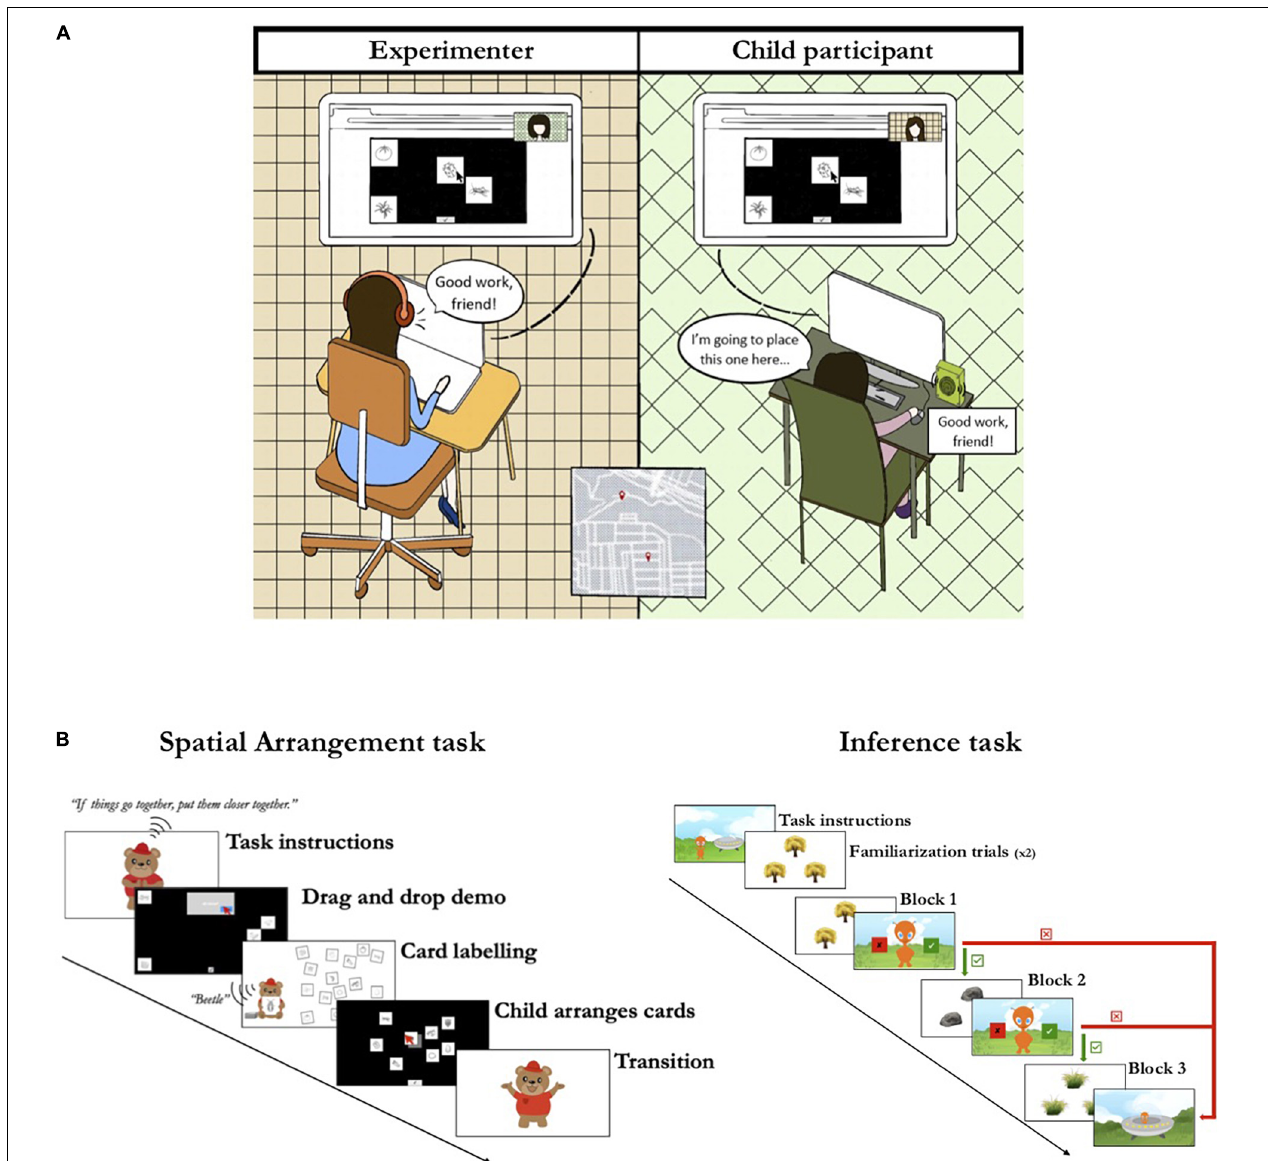
FIGURE 2 | Experimental procedures. (A) Illustration of the experimental setup. Children were tested remotely by a trained experimenter in the Zoom platform. Children completed the tasks on a browser window; the child shared their screen so the experimenter was able to help with any technological challenges. (B) Sequence of events in the Spatial Arrangement task (left) and the Inference task (right); the green and right boxes and arrows represent the adaptive procedure in which children were given the option of either completing the next block of trials (green) or ending the task